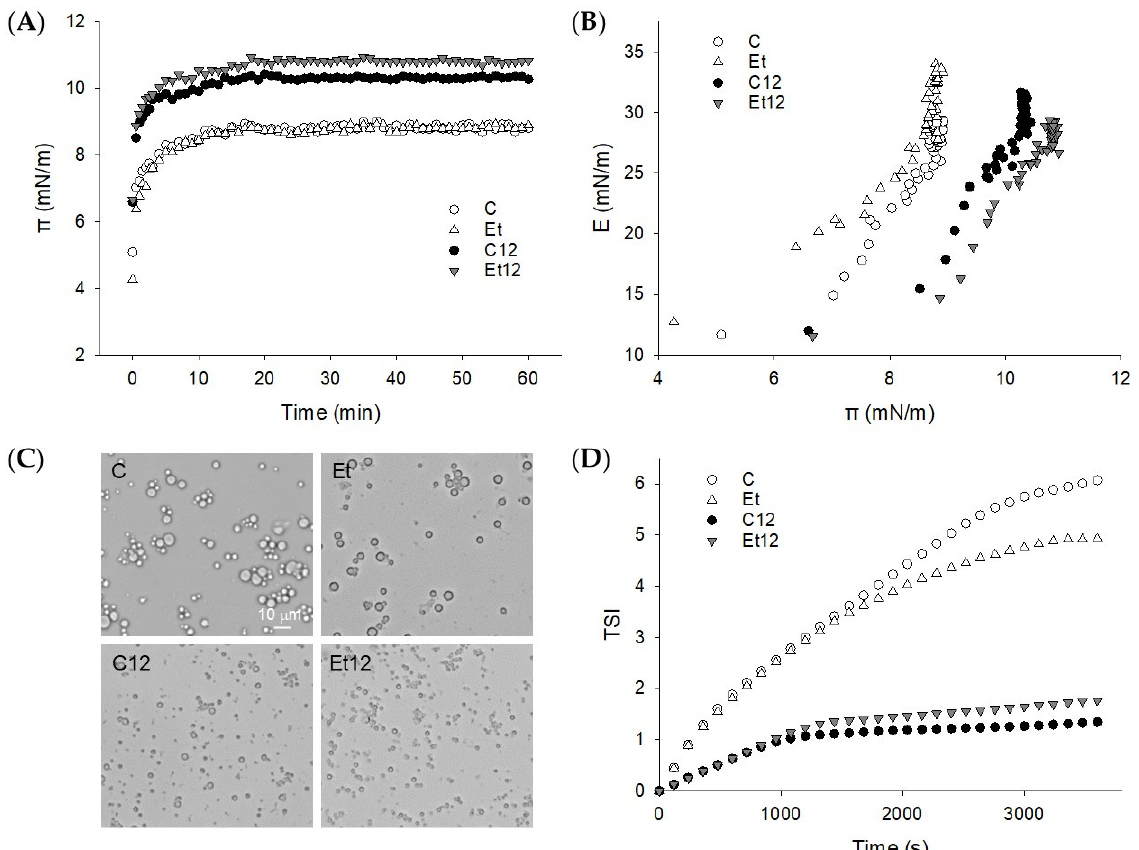
Figure 5. Dynamic surface pressure π -t curve ( A ) and surface dilatational modulus E- π curve ( B ) of proteins adsorbed at the oil–water interface. ( C ): light microscopy of fresh emulsions; ( D ): Turbiscan stable index (TSI) of the emulsions. Samples: C: control; Et: dephenoled with 70% ethanol; C12 and Et12: pH 12 shift-treated samples.